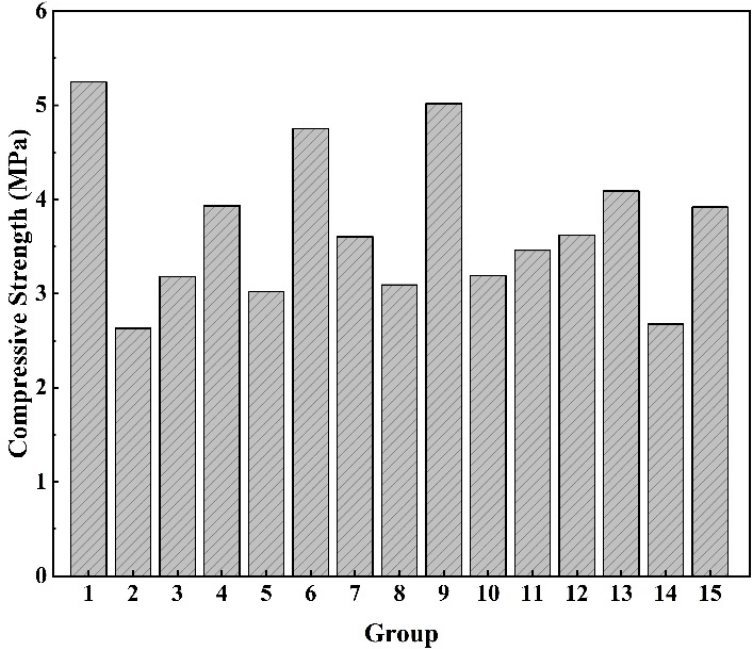
Figure 1. Compressive strength of MS1–MS15 samples.